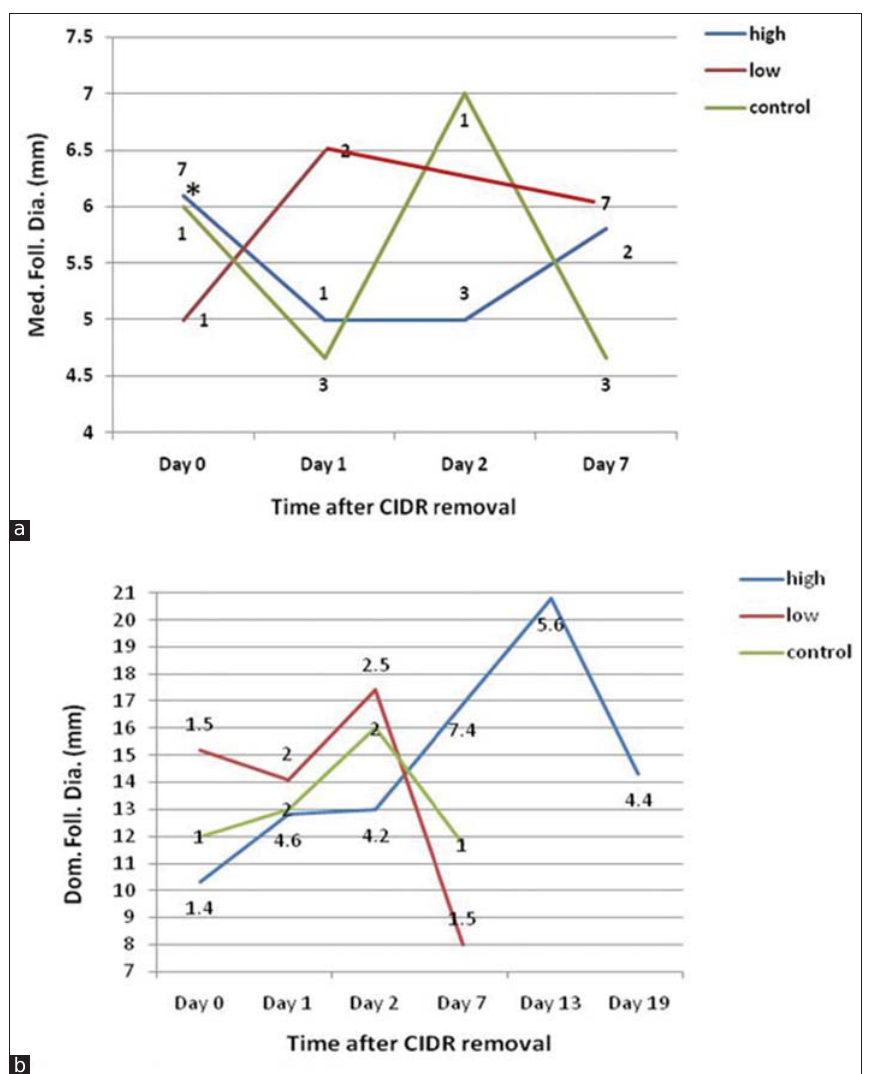
Figure-2: Number of medium (a) and large (b) follicles during days post controlled internal drug release removal in control, low and high-recombinant human follicle stimulating hormone -treated dairy